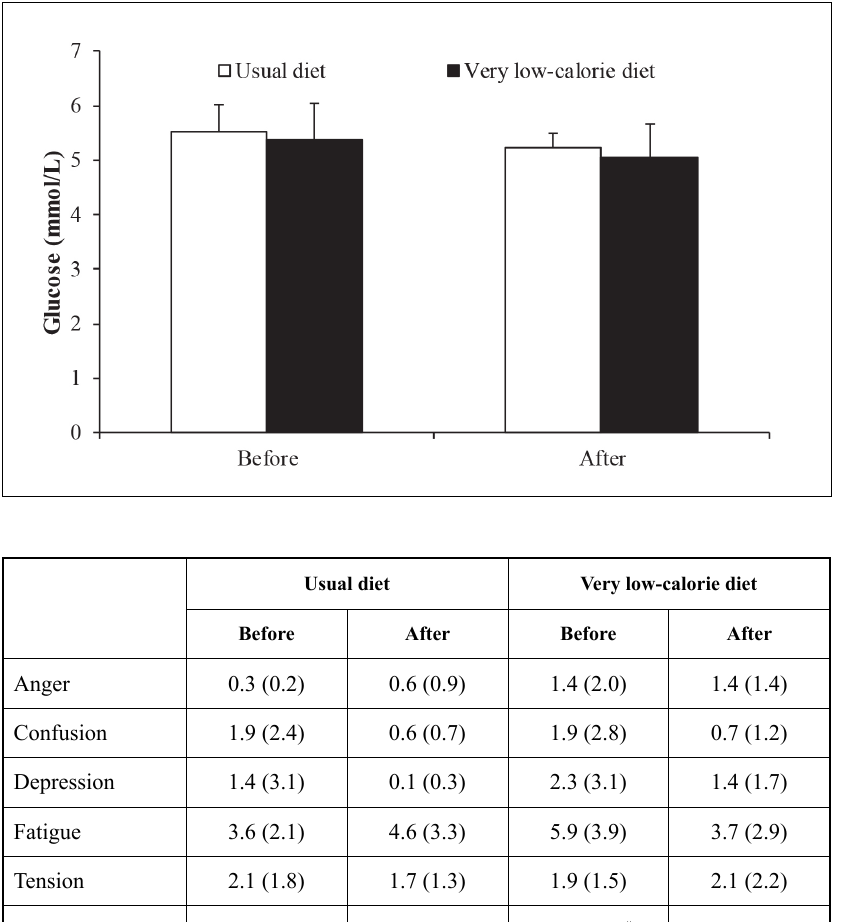
Figure. Effect of a 2-day very low-